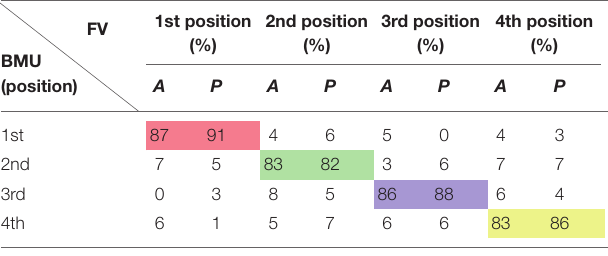
Red corresponds to position 1; Blue corresponds to position 2; Green corresponds to position 3; Yellow corresponds to position 4.